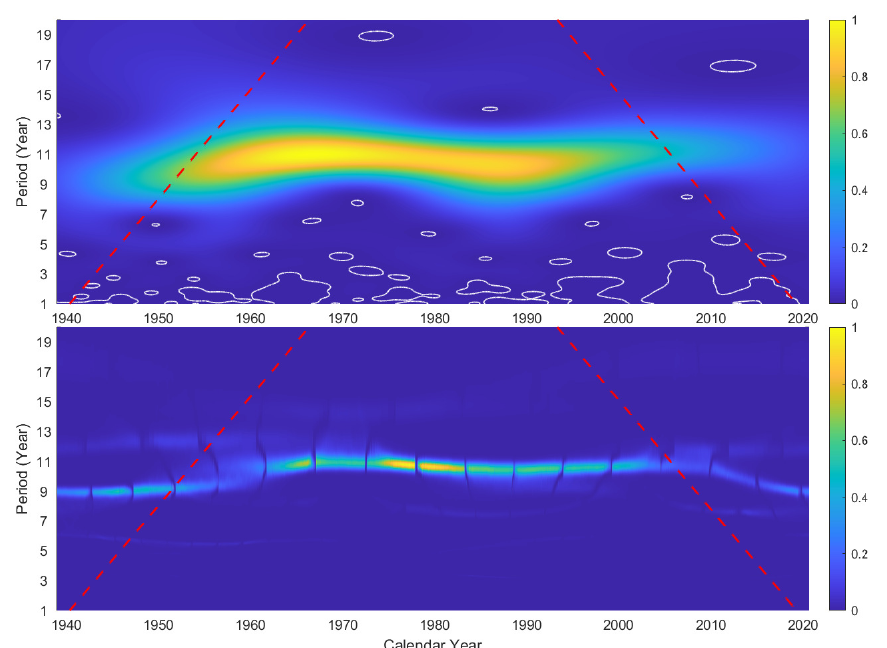
Figure 3. Time–frequency representation of the modified coronal index series with periods between 1 and 20-yr. ( Upper panel ): derived from the continuous wavelet transform [42]; the dashed red line is the cone of influence (COI); the solid white line is the 99% confidence level; ( Lower panel ): derived from the CWT-based ConceFT.